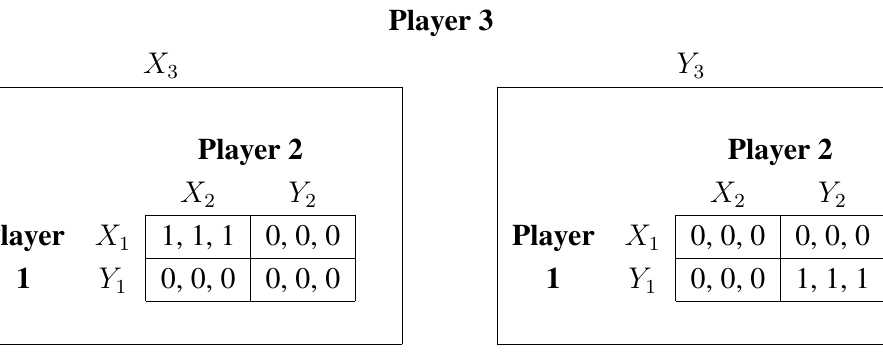
Table 5. Impulses in the direction of the alternative not